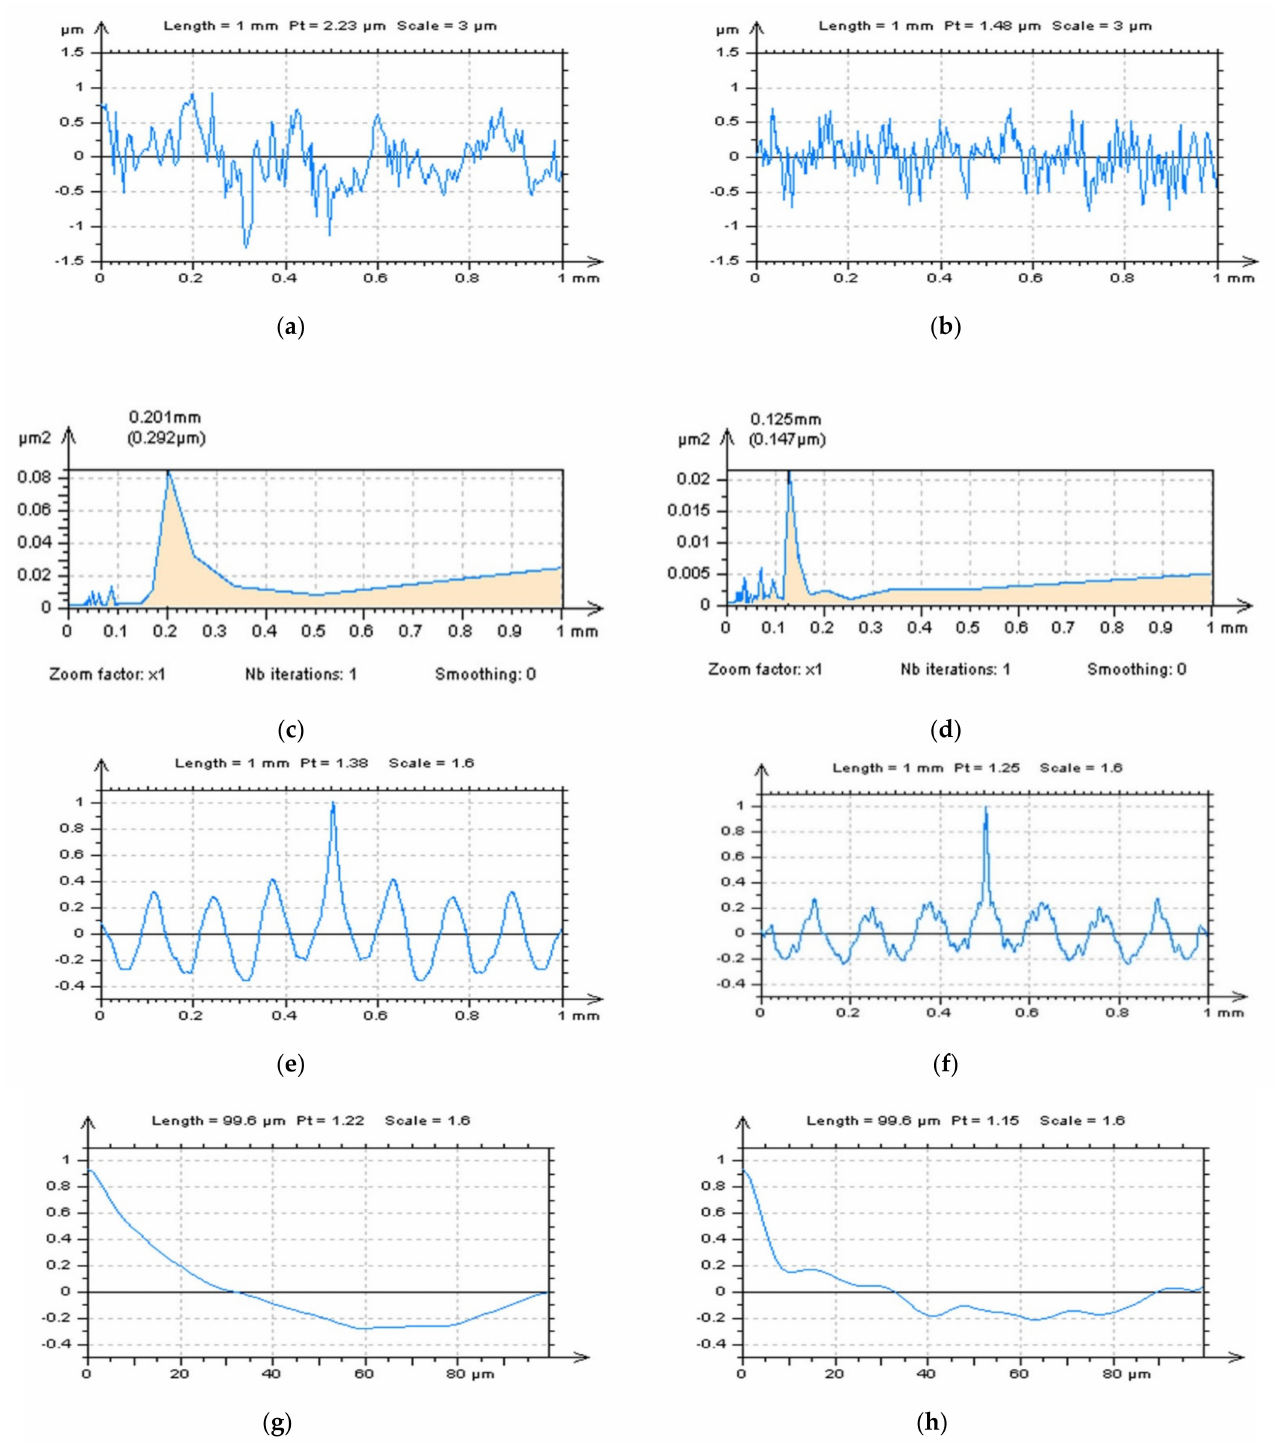
Figure 4. Profile (2D) analysis of the high-frequency measurement errors: measured profiles ( a , b ), their PSDs ( c , d ) and ACFs ( e , f ), and enlarged parts of the ACF graphs centres ( g , h ), received from milled surfaces M1(1) (left) and M1(2) (right column), respectively, after application of the TTP